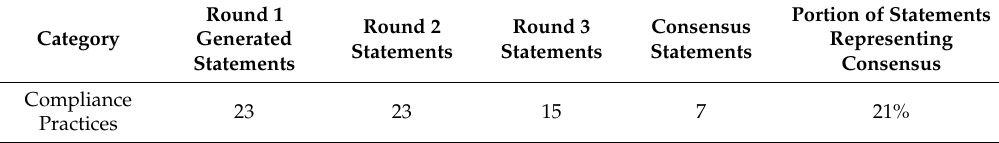
Table 1. Overall Study